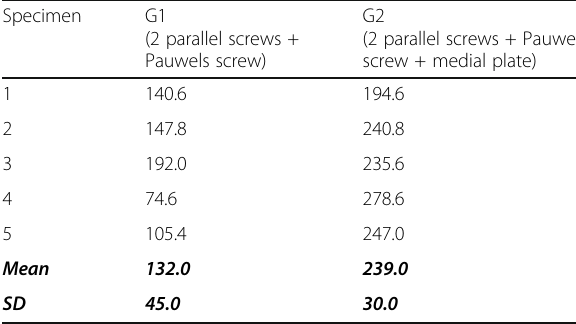
Table 3 Rigidity values, in N/mm Specimen